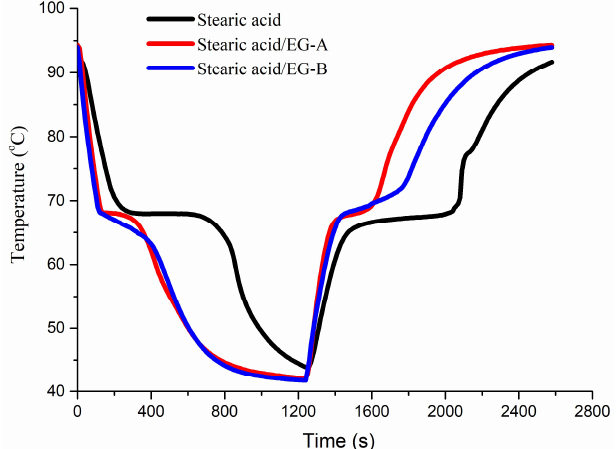
Figure 5. The thermal storage and release curves of stearic acid and stearic acid/EG composites.